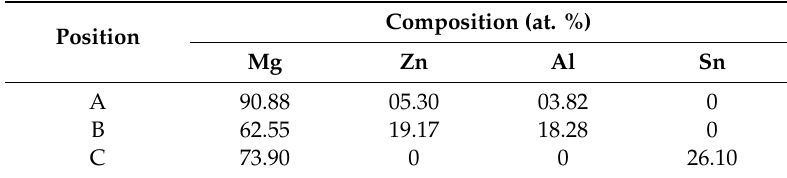
Table 2. Energy-dispersive X-ray spectroscopy (EDS) detection of extruded ZAT541 and ZAT542 alloys. Composition (at. Position